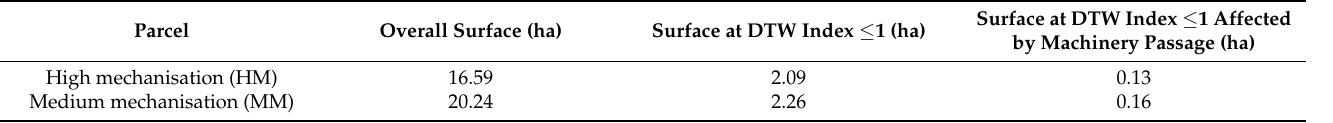
Table 1. Details of areas at DTW index ≤ 1 in the two investigated